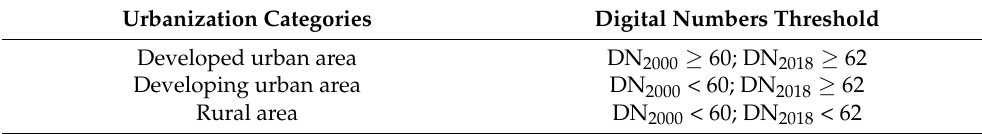
Table 2. Classification of urbanization level and indicators of digital numbers (DN) from nighttime light data.